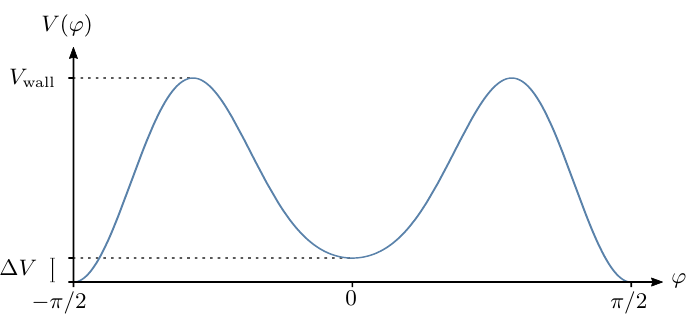
Figure 1 . The axion potential (1.1) for N/M = 3 . There is a minimum at ϕ ∗ = 0 with ∆ V ≡ V (0) ∝ g s (cid:15) 2 γ 2 / V 2 , γ (cid:28) 1 , while the potential scales as g s (cid:15) 2 / V 2 in